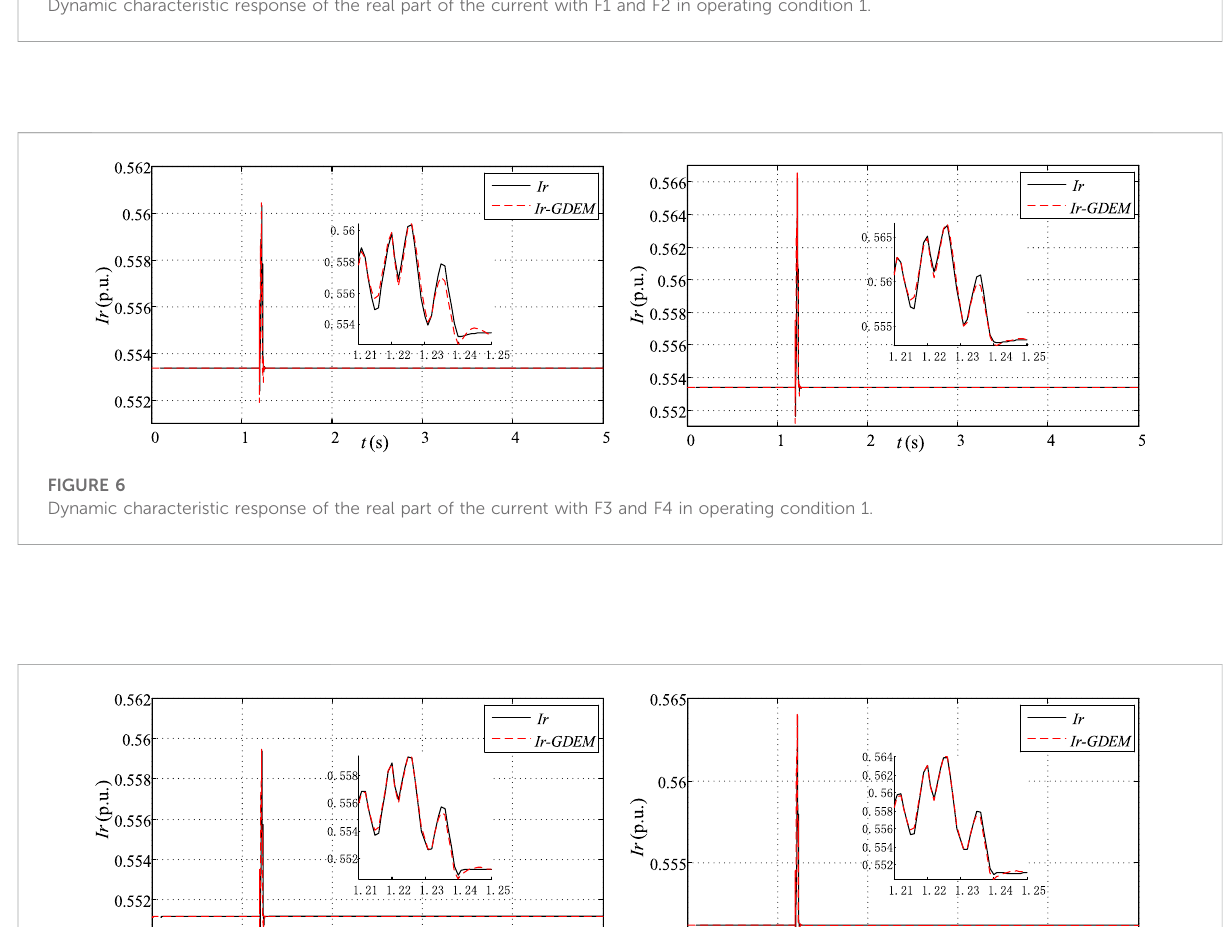
(PV penetrationratelevels in the is30%), respectively; the voltage at node 8 is 23 kV where the grid connection occurs. The PV